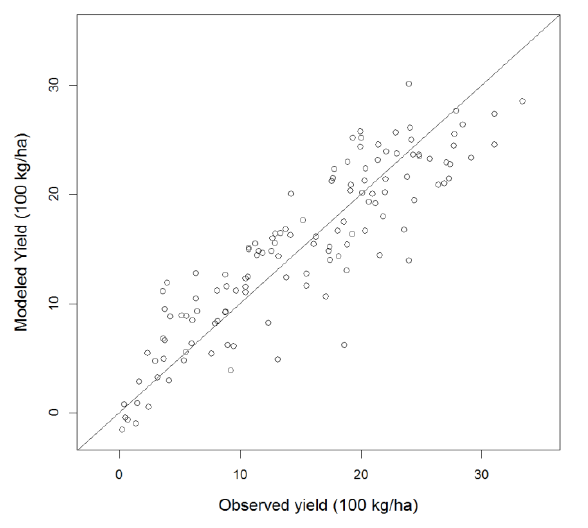
Figure 5. Modeled vs. observed yield scatterplot. Modeled points are jackknifed predictions . The 1:1 line is drawn for obtained with the FE model using CUM APAR